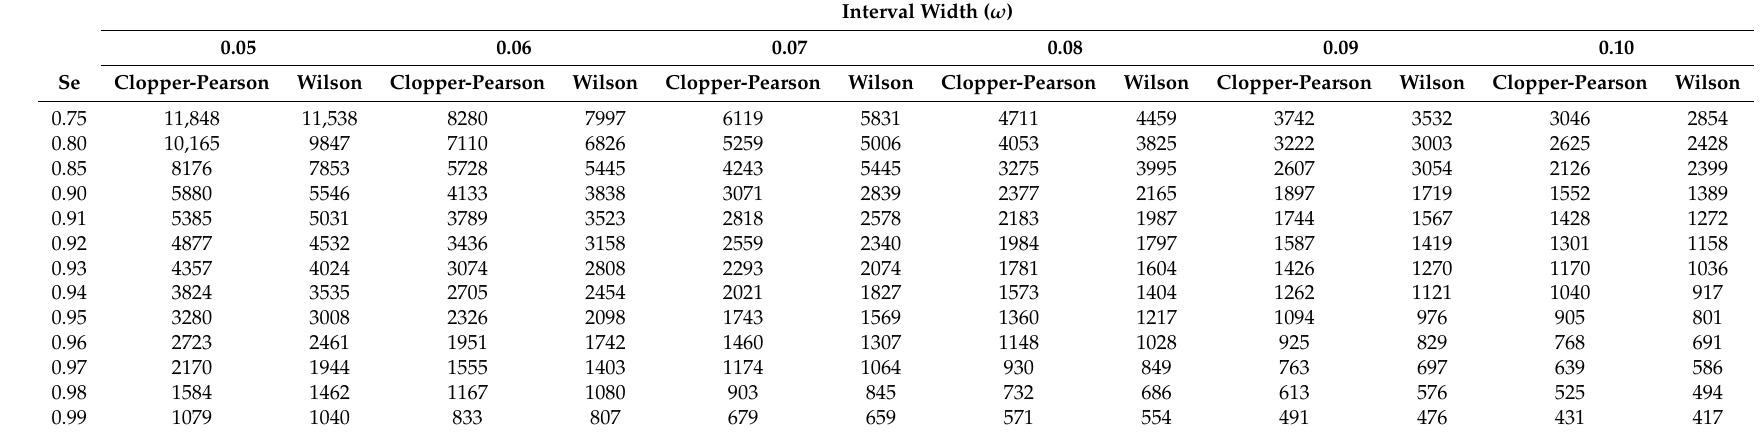
Table 3. Optimal sample sizes ( n optimal ) corresponding to several sensitivities, for the Clopper–Pearson and Wilson methods, with ω varying between 0.05 and 0.10, admitting η = 0.10, ξ = 10 − 4 , and 95% nominal confidence